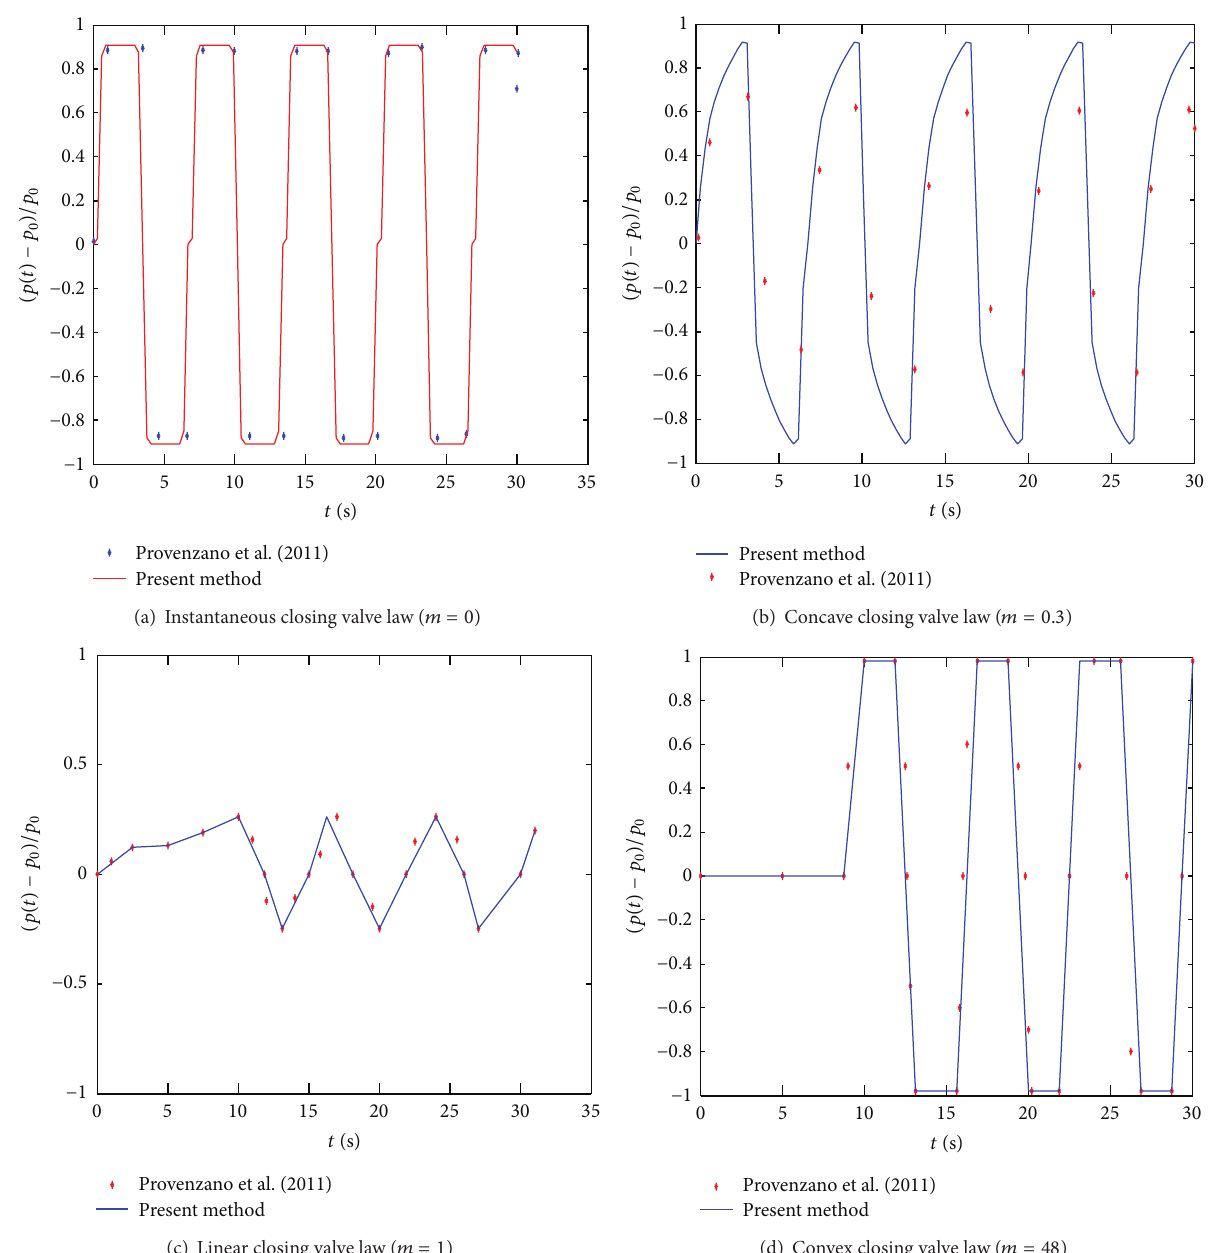
Figure 1: Transient pressure waves for different types of closing valve laws (comparison present method (ROM) with analytical method) [5].